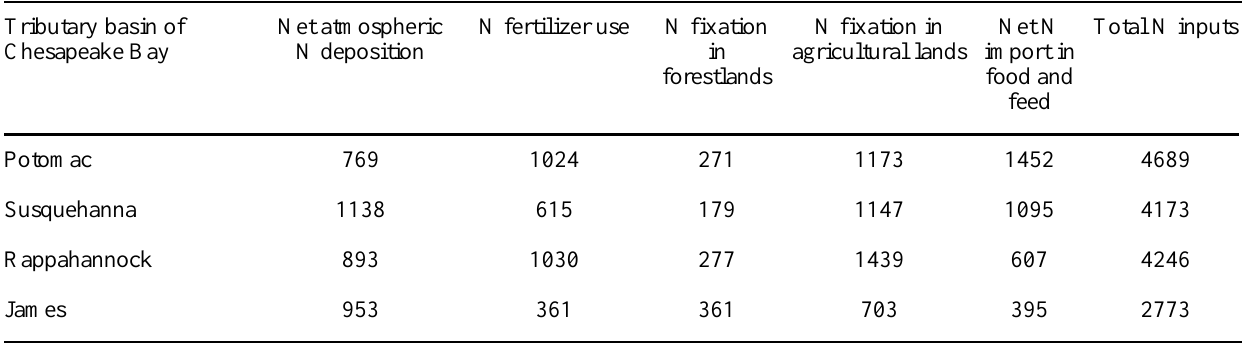
Table 1. Overall nitrogen budget for the Potomac River basin and the four major tributary basins of Chesapeake Bay. The Potomac River basin has the largest net nitrogen (N) import in food and animal feed of the four major